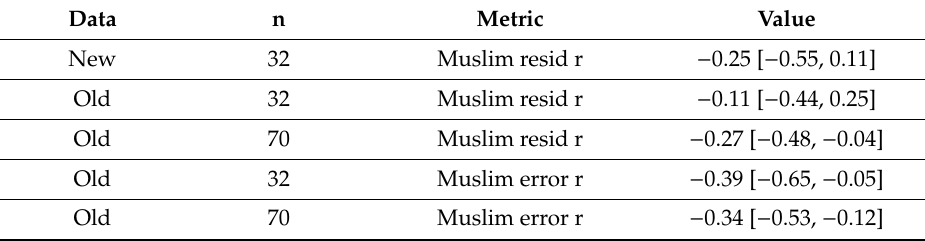
Table 2. Comparison of Muslim bias in aggregate stereotypes across methods and datasets. New data is from the present study. Old data is from Kirkegaard and Bjerrekær [6]. The calculations in the second and fourth rows (n = 32) were done in the sub-sample of the old data comprising the countries available in the new data.